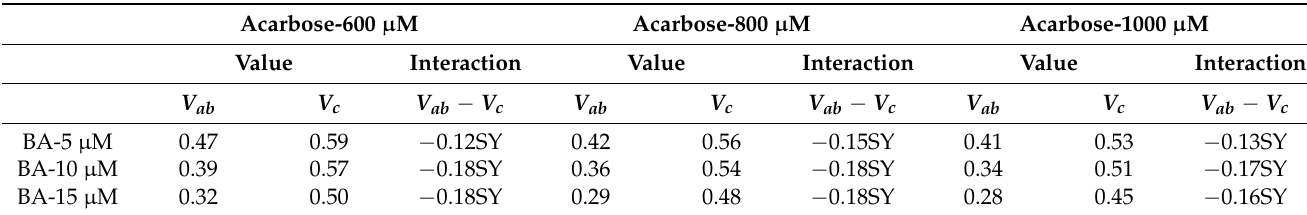
Table 1. Synergistic effect of acarbose with BA on the inhibitory activity of α -glucosidase*. Acarbose - 600 μM Acarbose - 800 μM